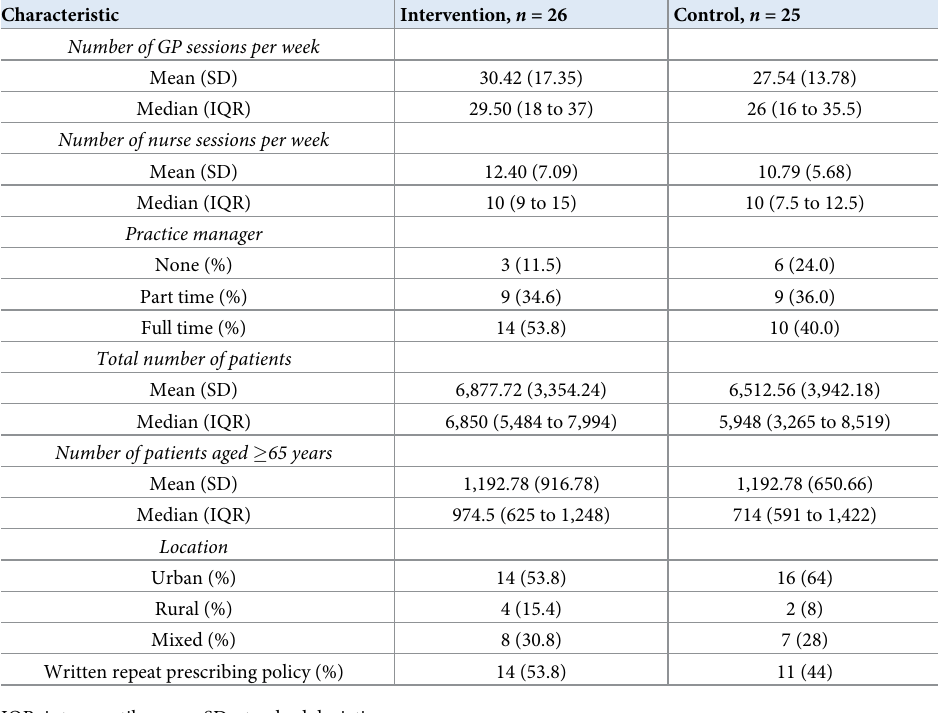
Table 1. Practice details in each group at